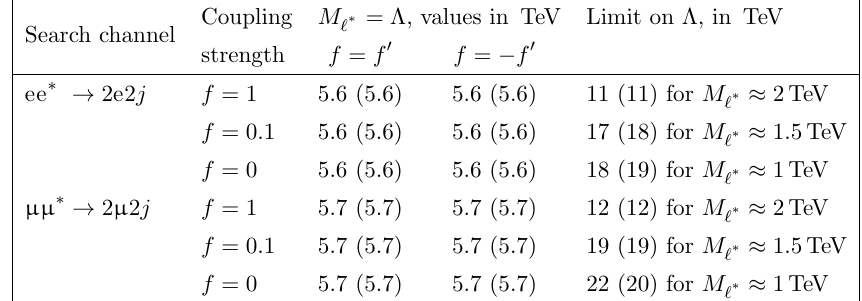
Table 2 . Summary of the observed (expected) limits on ‘ (cid:3) mass, assuming M f = f 0 and f = f 0 . The limits evaluated in terms of the compositeness scale (cid:3) are shown in the (cid:0) right